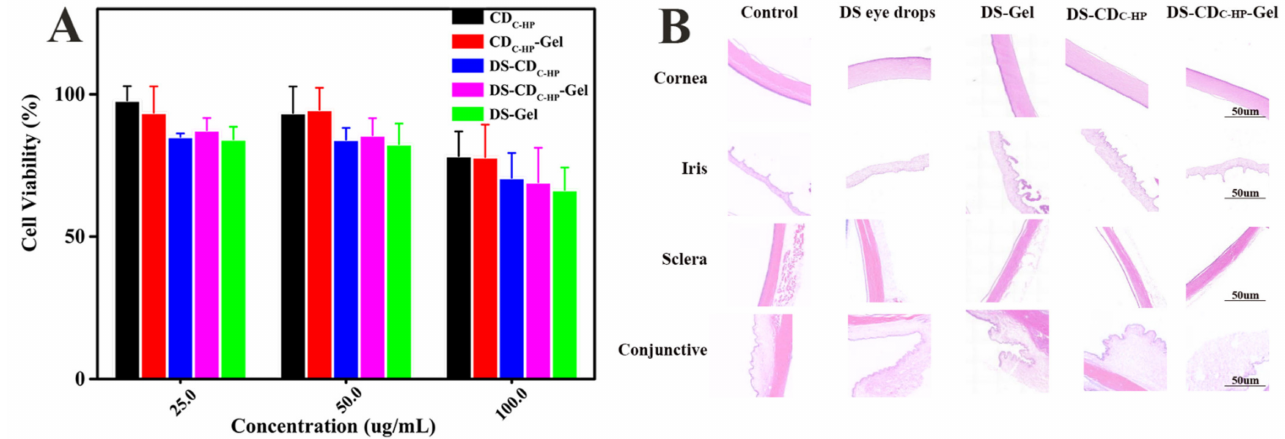
Figure 5. In vitro cytotoxicity of different formulations for 24 h ( A ); Histopathological microscopy of ocular tissues after treatment for a week ( B